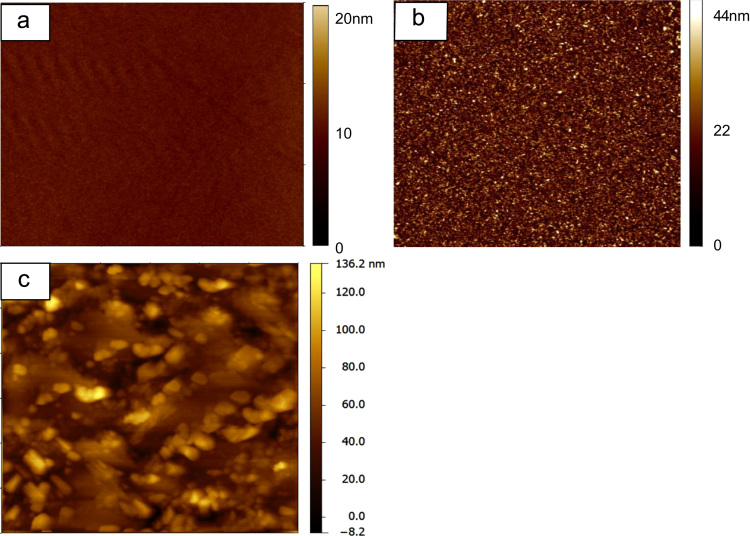
Atomic Force Microscopy top view images of (a) glass substrate; (b) TiO2; (c) CH3NH3PbI3 thin film.